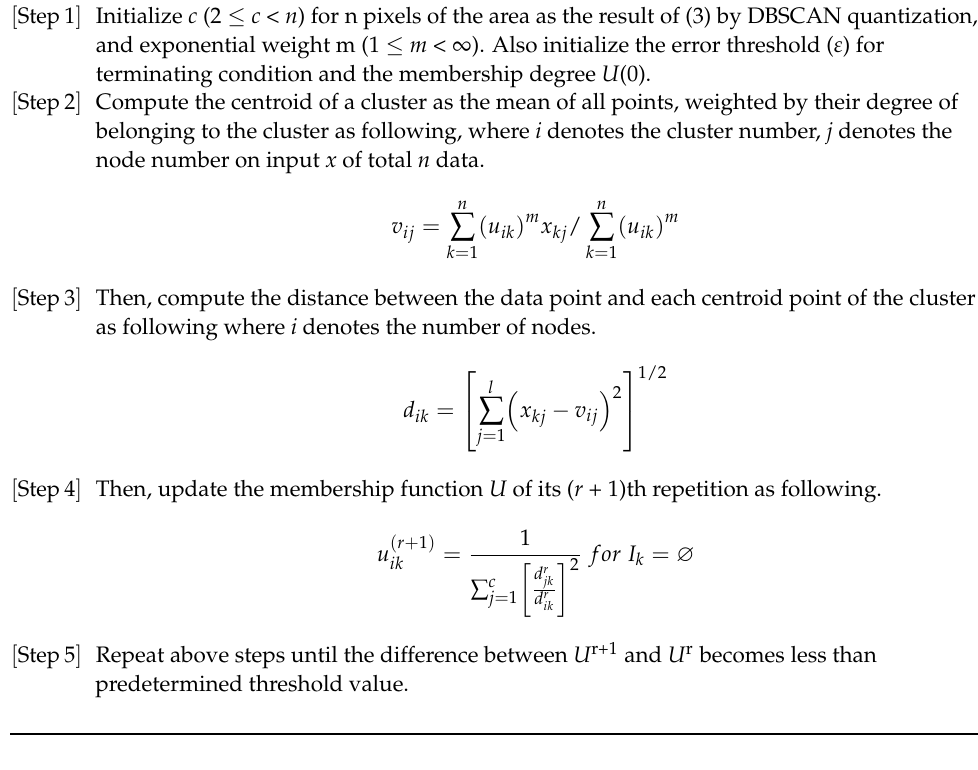
Algorithm 2. FCM quantification Algorithm 2 FCM quantification process.